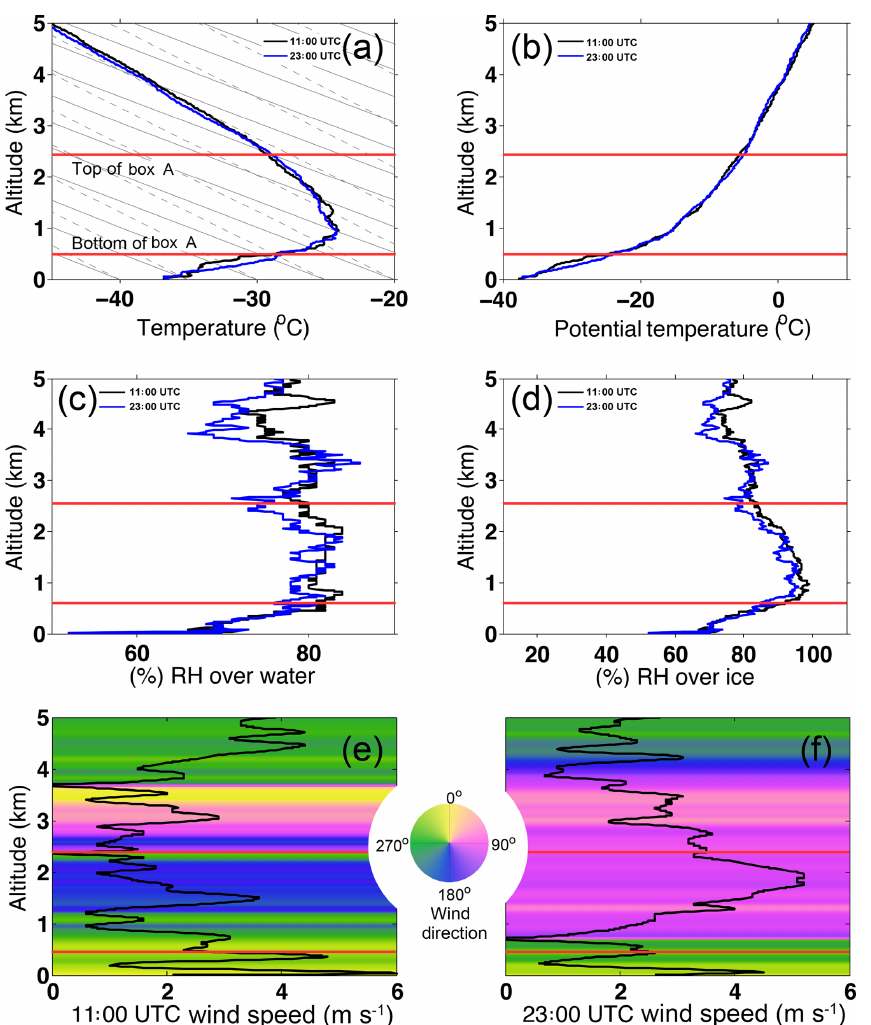
Figure 5. 21 March 2017. From the two daily radiosondes launched by the Eureka Weather Station. Panel (a) is the temperature; solid grey lines are dry adiabats, and dashed grey lines are moist adiabats. Panel (b) is the potential temperature. Panels (c, d) are the relative humidity with respect to water and ice, respectively. Panels (e, f) are the wind speed (black line) and direction (coloured background). Red lines show top and bottom altitudes of Box A from Fig.